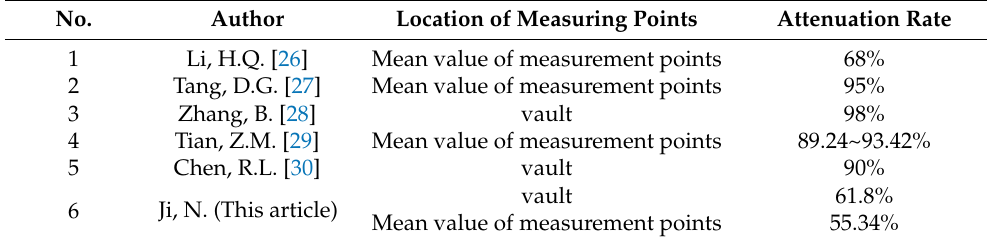
Table 8. The attenuation rate of the foam concrete backfill layer to the peak stress. No. Author Location of Measuring Points Attenuation Rate Li, H.Q.